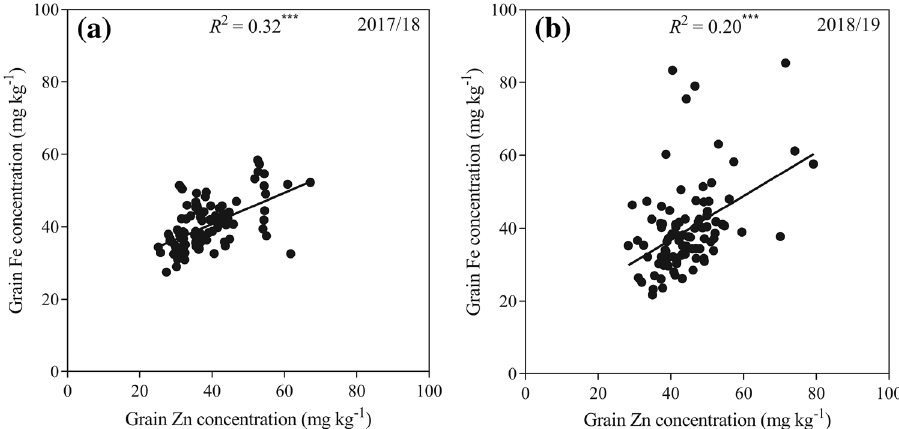
Figure 3. Correlations between Zn and Fe concentration in grains of 93 wheat accessions in ( a ) 2017/18 and ( b ) 2018/19 wheat growing seasons. Note: *** indicates statistically significant at P < 0.001 level.